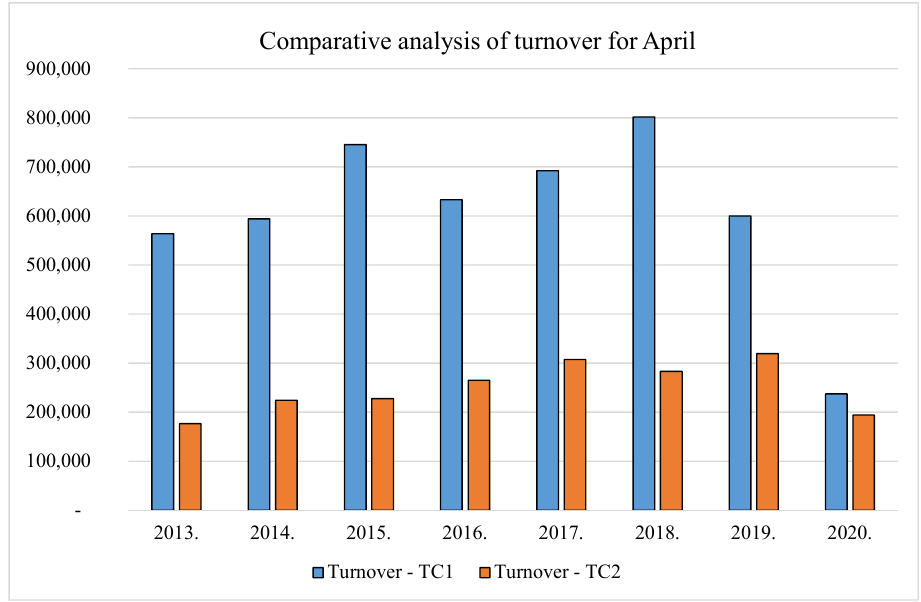
Figure 8. Graphical representation of comparative analysis of turnover for